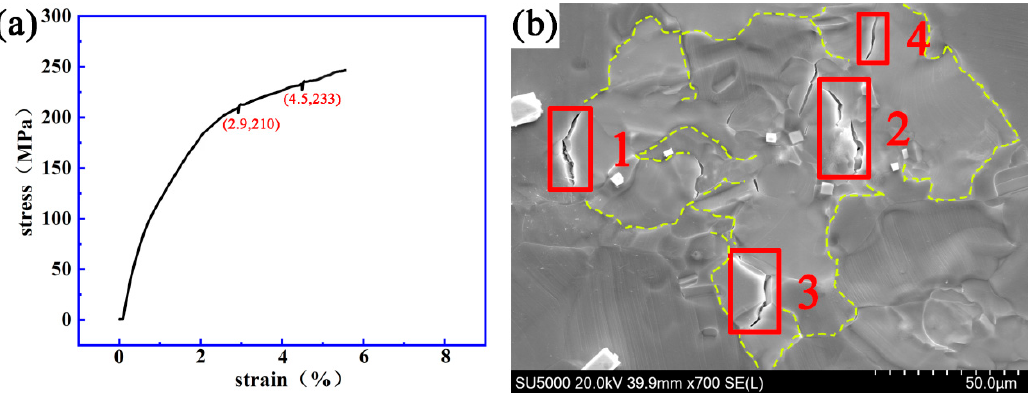
Figure 10. The dynamic change process of crack initiating and extending a Mg-13Gd-5Y-3Zn-0.3Zr alloy after solution treatment at 510 °C for 22 h. ( a ) The stress–strain curve. ( b ) The evolution process of the micro-crack.